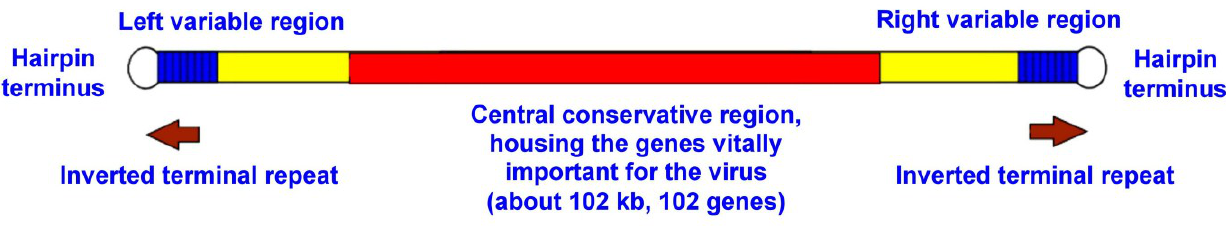
Figure 1. Scheme of orthopoxvirus genome (not to